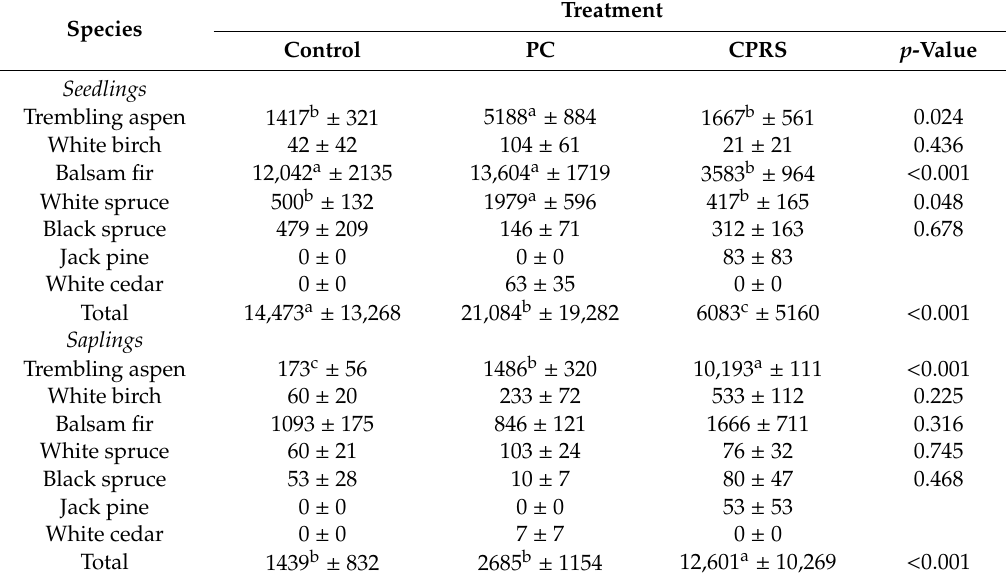
± 1 < DBH ≤ 9.0 cm across treatments and species 7 to 19 years after treatment in the studied boreal mixed-woods. On a given line, values with di ff erent letters di ff er significantly based on Tukey HSD comparisons ± α =